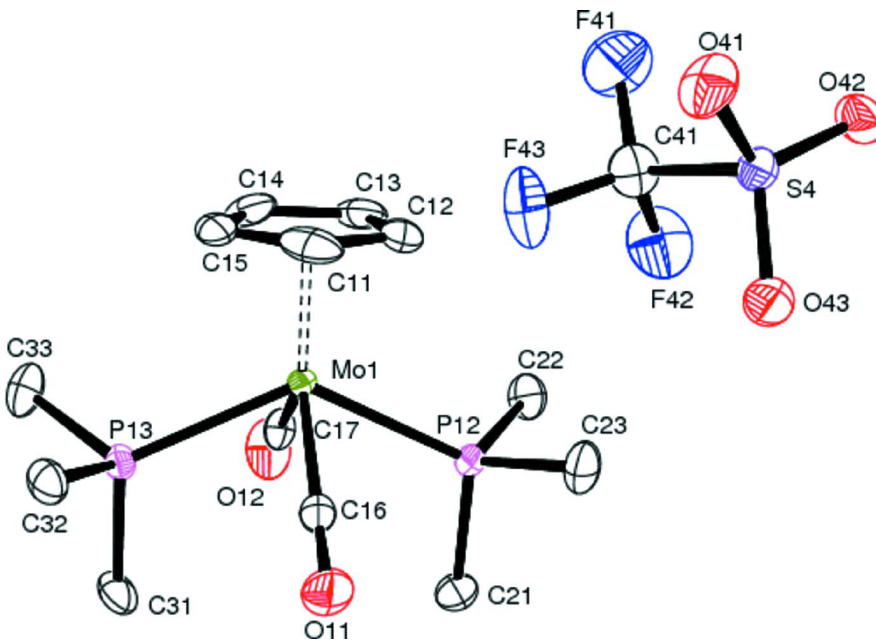
Figure 1 Molecular structure of the title complex with the atom labelling scheme. Hydrogen atoms are omitted for clarity. Ellipsoids are drawn at the 50% probability